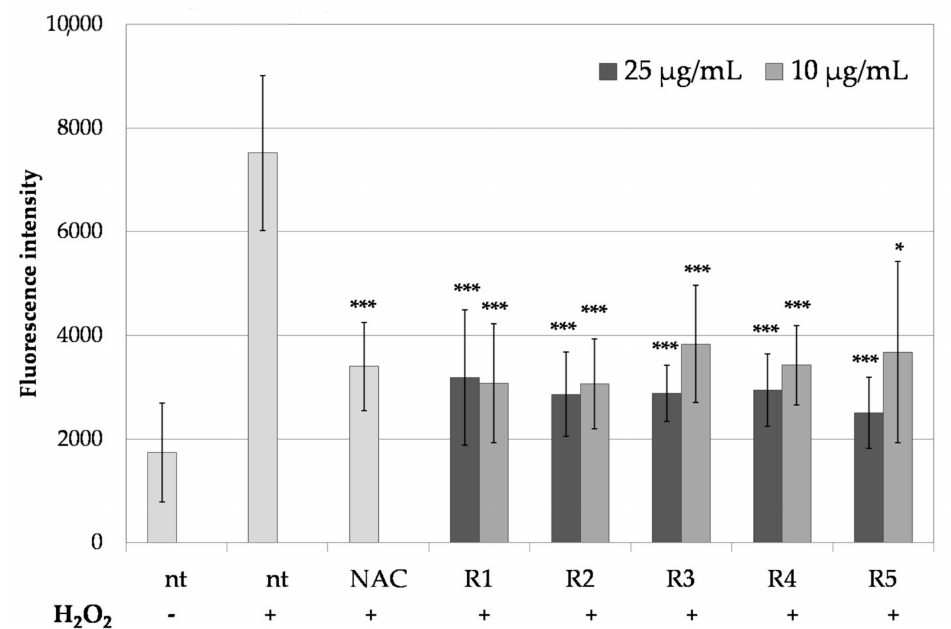
Figure 1. The effect of R1–R5 R. platyacantha extracts on the intracellular ROS levels in HaCaT ker- atinocytes treated for 60 min with 1 mM H 2 O 2 ; nt—no pre-treatment, NAC—2 mM N-acetylcysteine; values on graph represent mean ± SD ( n = 3), *** p < 0.001, * p < 0.05 in comparison with “nt + H 2 O 2 ” sample.